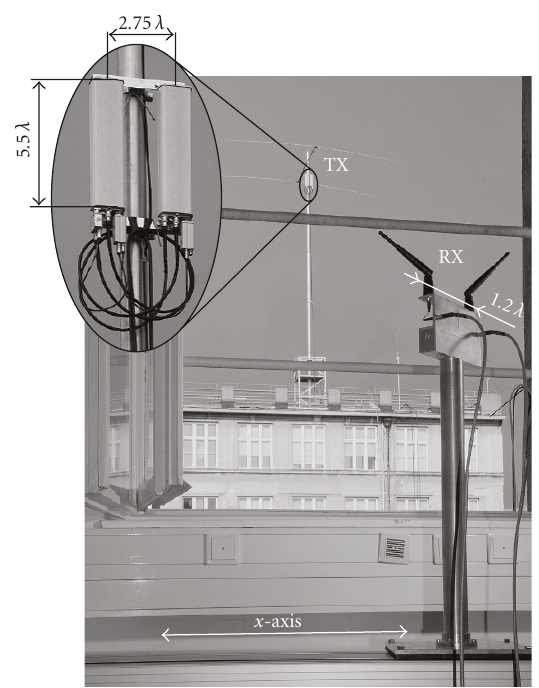
Figure 2: Transmit and receive antenna setups in the outdoor-to- indoor LOS